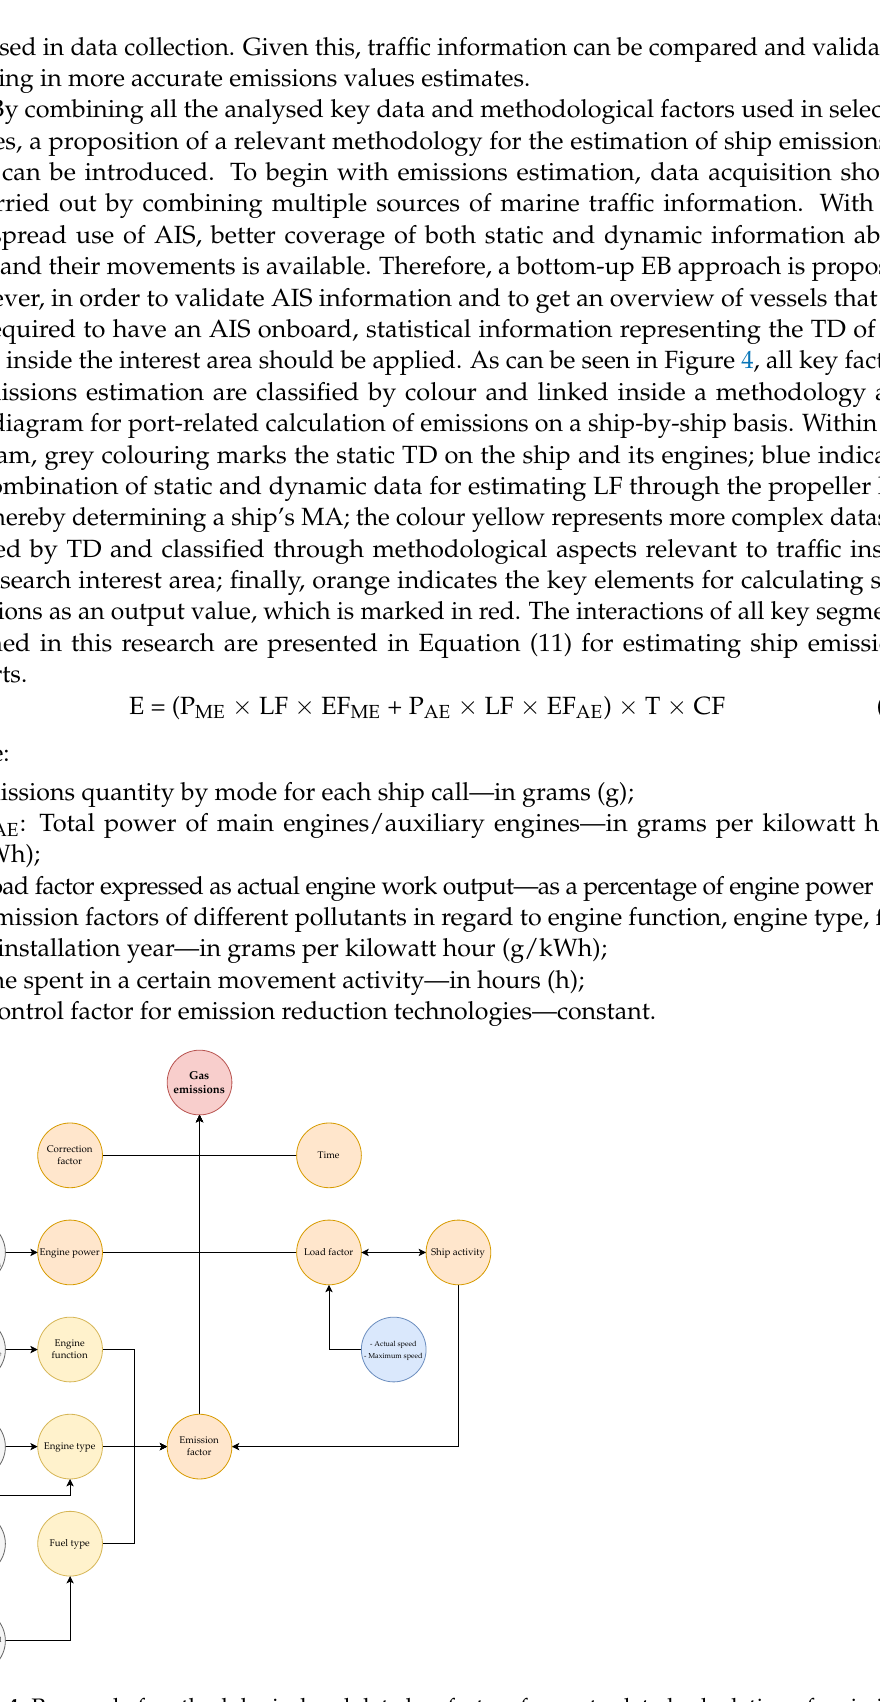
Figure 4. Proposal of methodological and data key factors for port-related calculation of emissions on a ship-by-ship